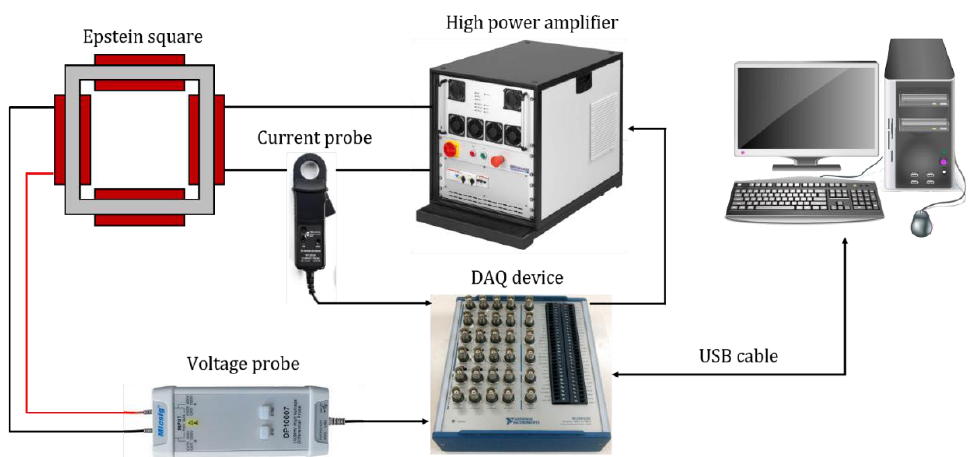
Figure 1. Test bed to measure dynamic hysteresis loops with the Epstein square under controlled magnetic-induction waveforms.